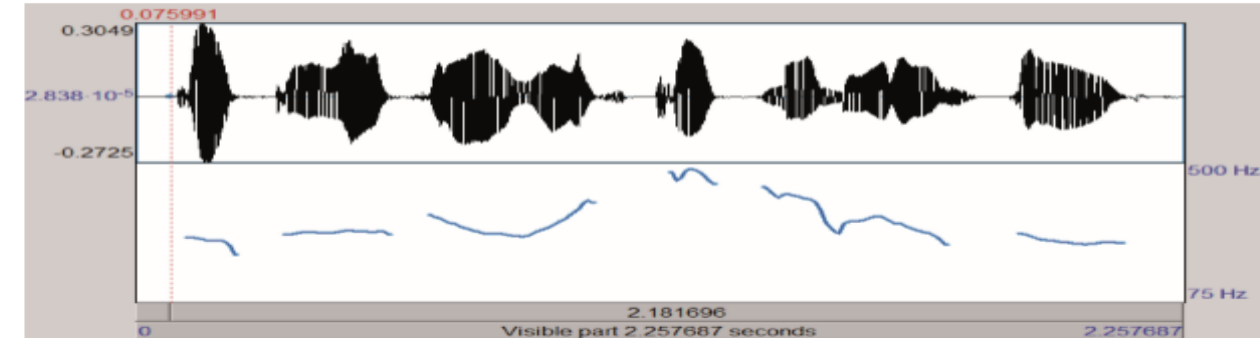
Fig.4 Pitch contour for Happiness